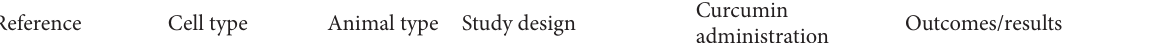
Table 1: Publications examining the stem/progenitor cell proliferative properties of curcumin. BrdU, bromodeoxyuridine; 𝜇 M, micromolar.